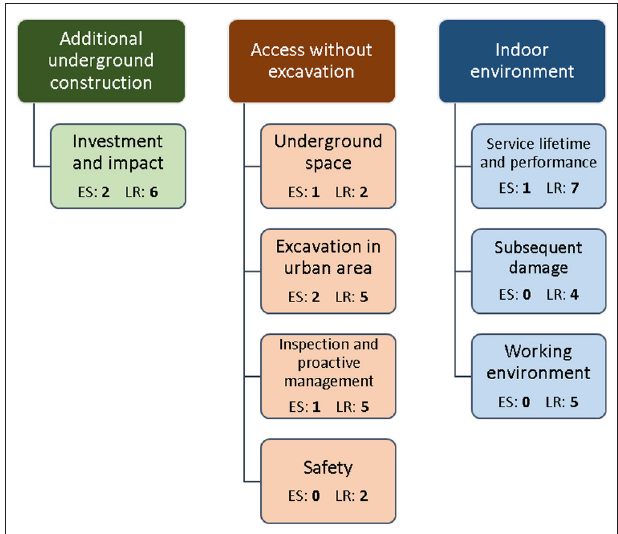
FIGURE 3 | Sustainability claims sorted into three categories. ES is the number of articles that present empirical support for their claims, and LR is the number of articles that support their claims with logical